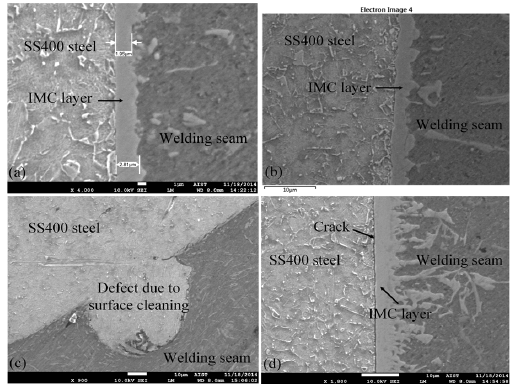
Figure 6. SEM microstructure at area between the welding seam and SS400 steel sheet: ( a ) IMC layer area; ( b ) without IMC layer area; ( c ) defects due to surface cleaning; and ( d ) microstructural crack on the surface of the steel sheet.